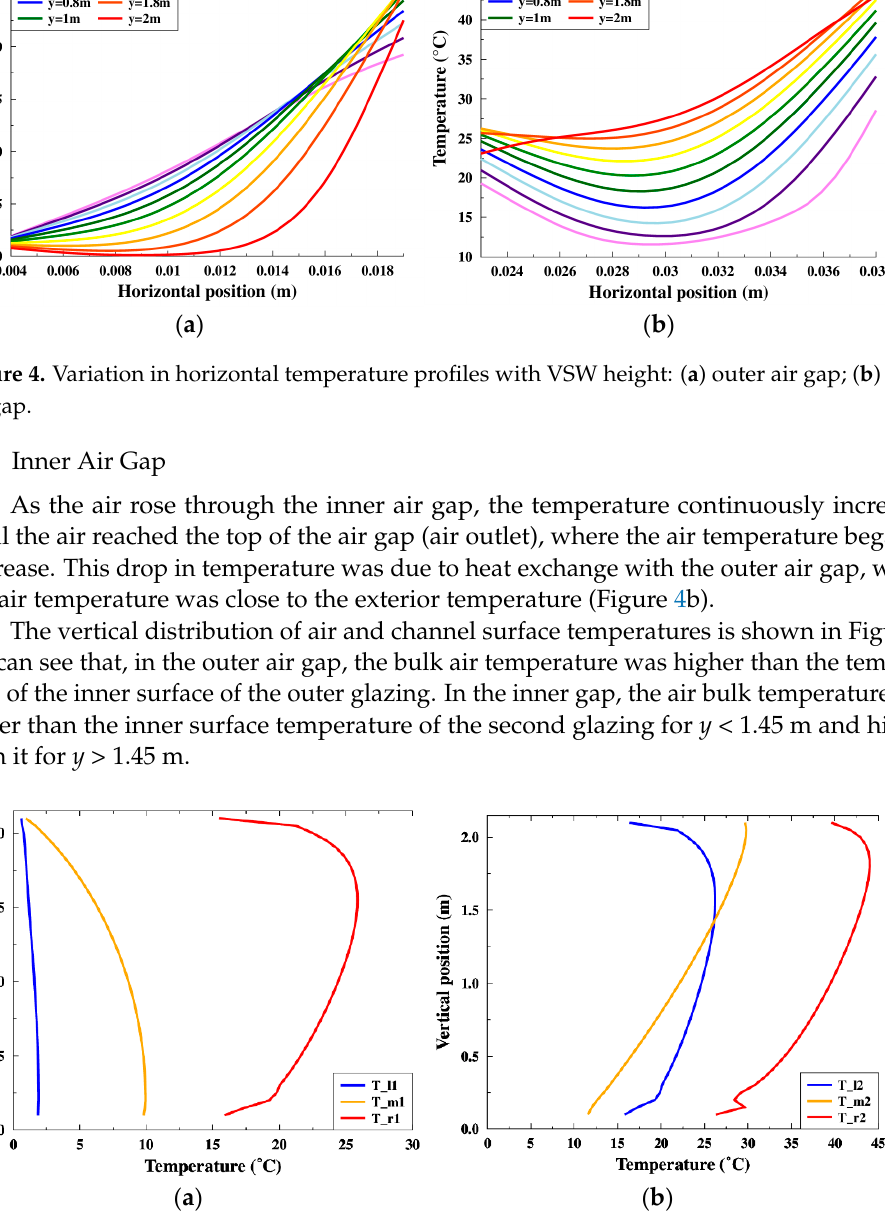
Figure 5. Temperature evolution of air and channel surfaces with VSW height: ( a ) outer air gap; ( b ) inner air gap. T_l and T_r represent the temperatures of the left and right surfaces of the air channel, respectively, and T_m represents the air bulk temperature.